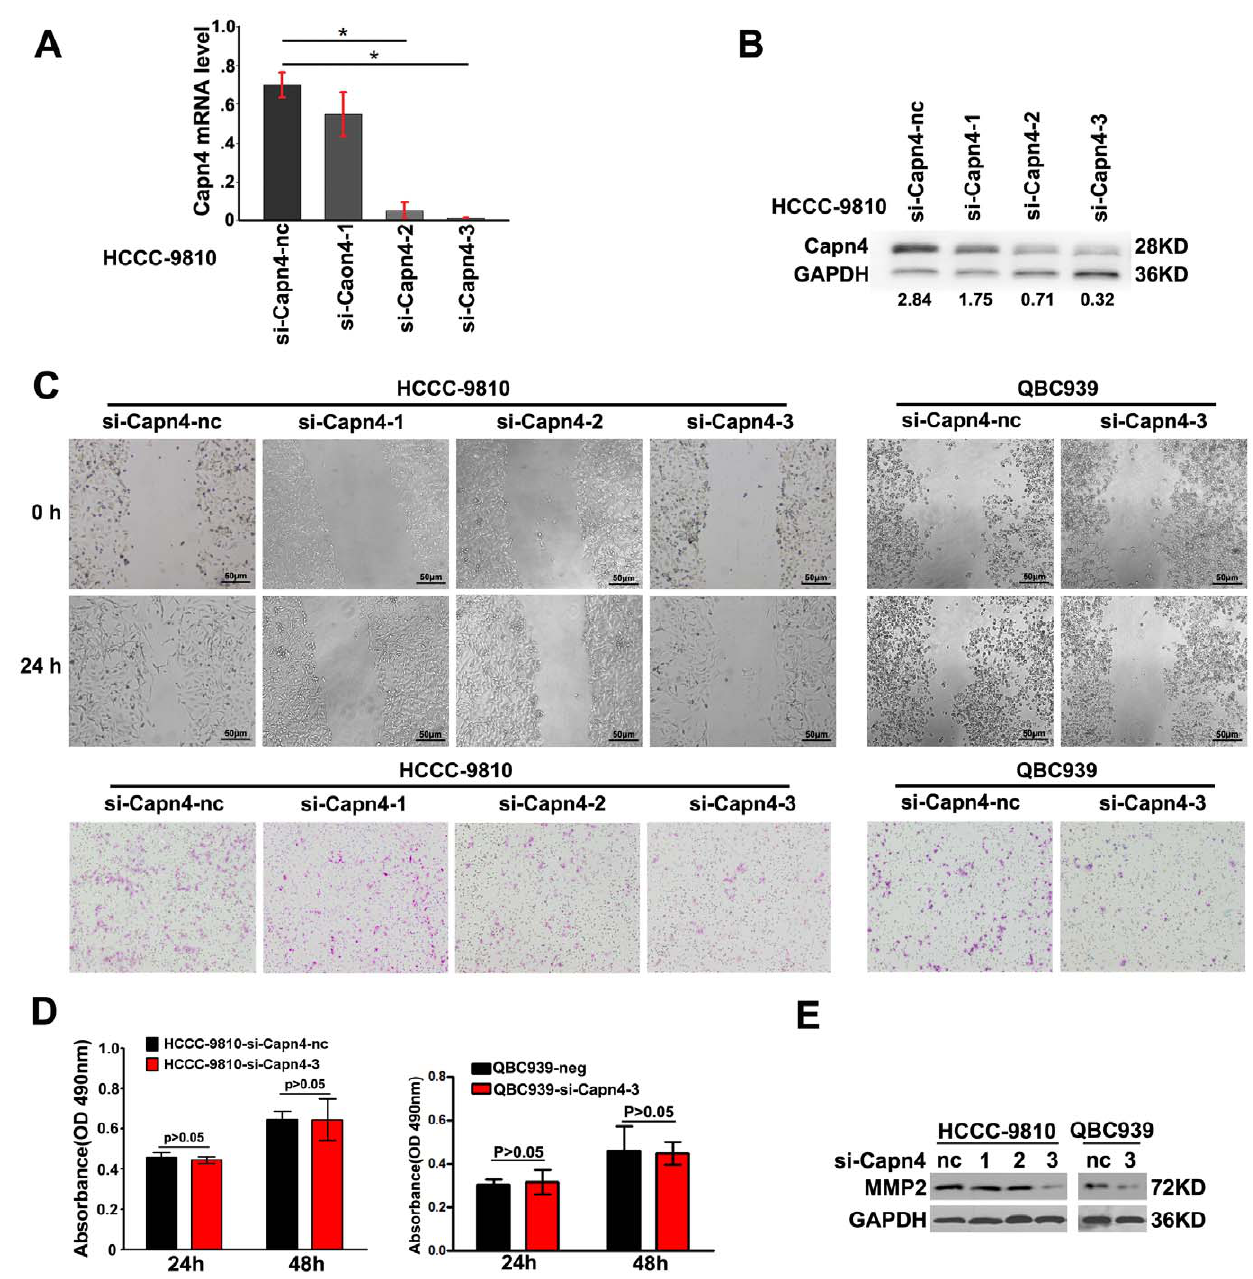
Figure 1. Functional analysis after transfection with Capn4 small interfering RNA (siRNA ) in HCCC-9810 and QBC939 cells invitro. ( A, B ) Among the siRNAs targeting Capn4, the third siRNA was validated as the most efficient siRNA using qRT-PCR and western blot analysis. ( C ) The HCCC-9810 and QBC939 cells transfected with Capn4 siRNA migrated slowly compared to the siCapn4-nc at 24 h in the wound assay. The transwell assays also showed that decreased Capn4 expression was accompanied by impaired invasiveness of HCCC-9810 and QBC939 cells (original magnification, 6 100, scale bar=50 m m). ( D ) Cell proliferation was detected by the 3-(4,5-dimethylthiazol-2-yl)-2,5-diphenyltetrazolium bromide assay. OD indicates optical density. ( E ) Capn4 expression positively correlated with MMP2 expression in the western blot